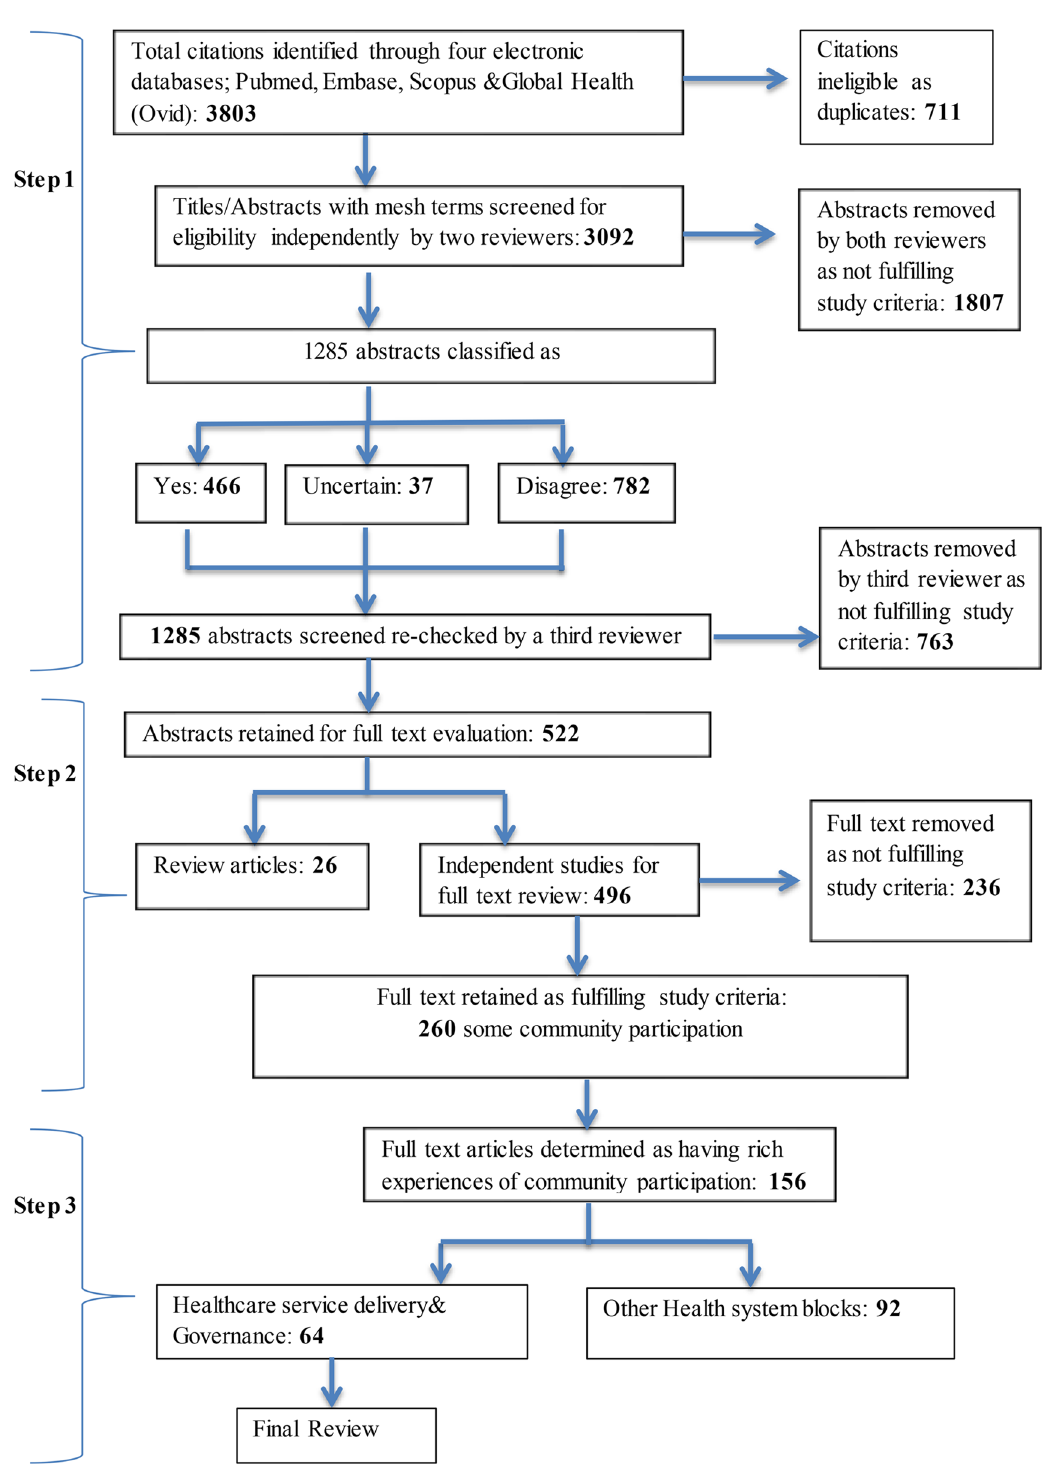
Fig 1. Flow chart detailing article selection